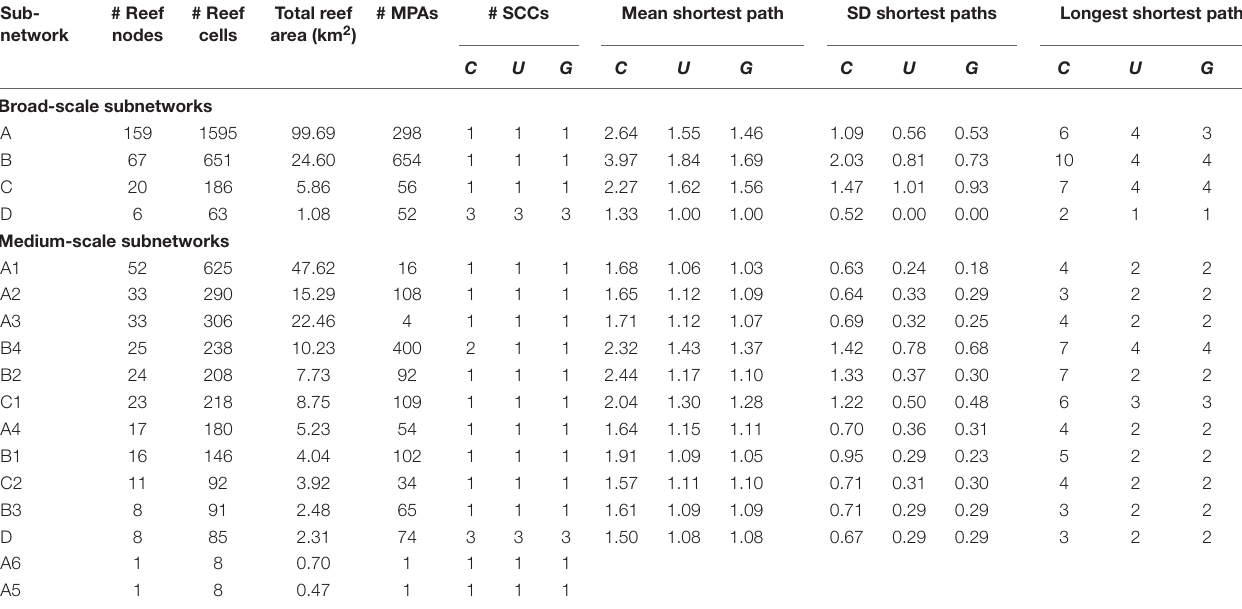
TABLE 4 | Reef area, MPAs, and topology of the